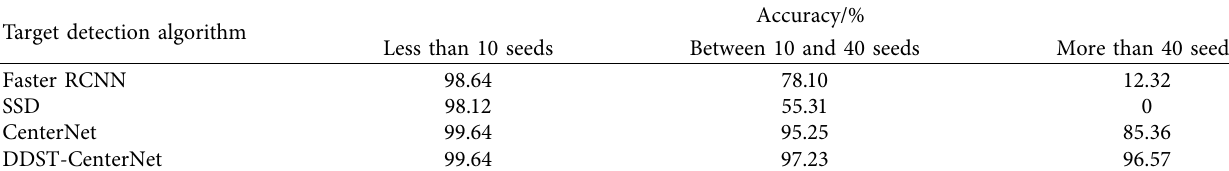
Table 1: Comparison of the accuracy of various algorithms. Target detection